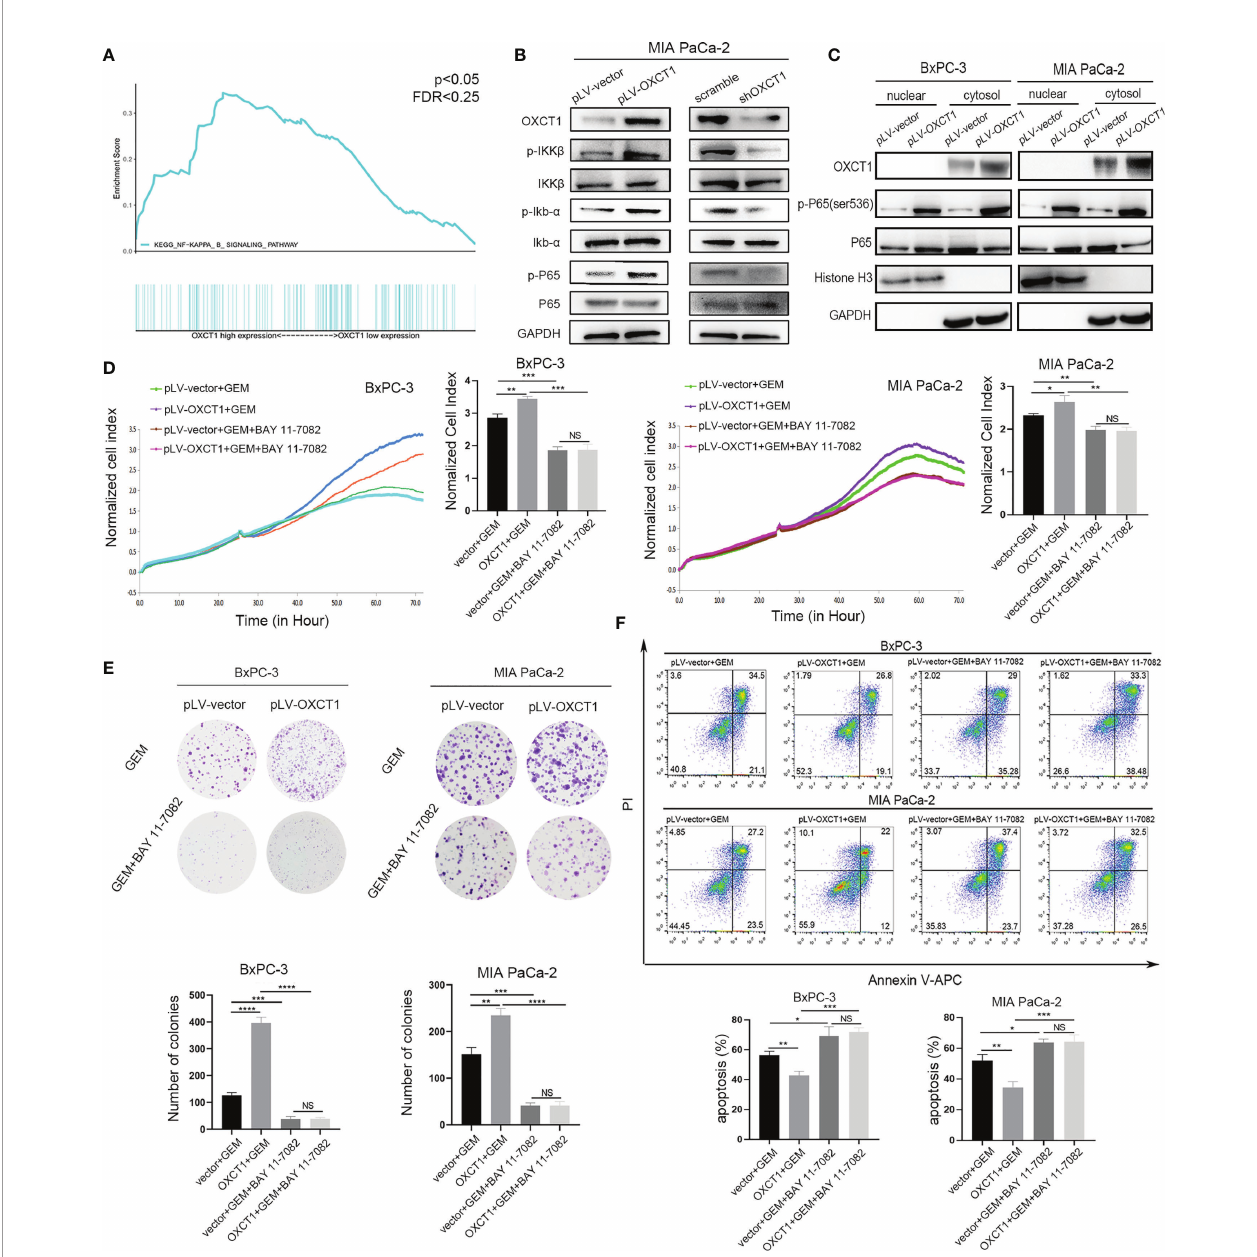
FIGURE 4 | OXCT1 promoted GEM resistance through the NF- k B signaling pathway. (A) The TCGA dataset was subjected to GSEA on the basis of OXCT1 expression. (B) The expression levels of p-IKK b , p-Ikb- a , and p-P65 in MIA PaCa-2 cell lines with OXCT1 overexpression and knockdown were detected using western blot analysis. (C) Western blot analysis of the fractionated BxPC-3 and MIA PaCa-2 cells stably transfected with the empty vector or OXCT1. (D – F) BxPC-3 and MIA PaCa-2 cell lines with or without OXCT1 overexpression were treated with GEM or the combination of GEM and BAY 11-7082. Cell cytotoxicity was analyzed using RTCA (D) . Cell cloning capability was analyzed using the colony formation assay (E) . Apoptosis was detected via fl ow cytometry (F) . The data are expressed as mean ± SEM from three independent experiments. * P < 0.05; ** P < 0.01; *** P < 0.001; **** P < 0.0001 (one-way ANOVA). NS, not signi fi